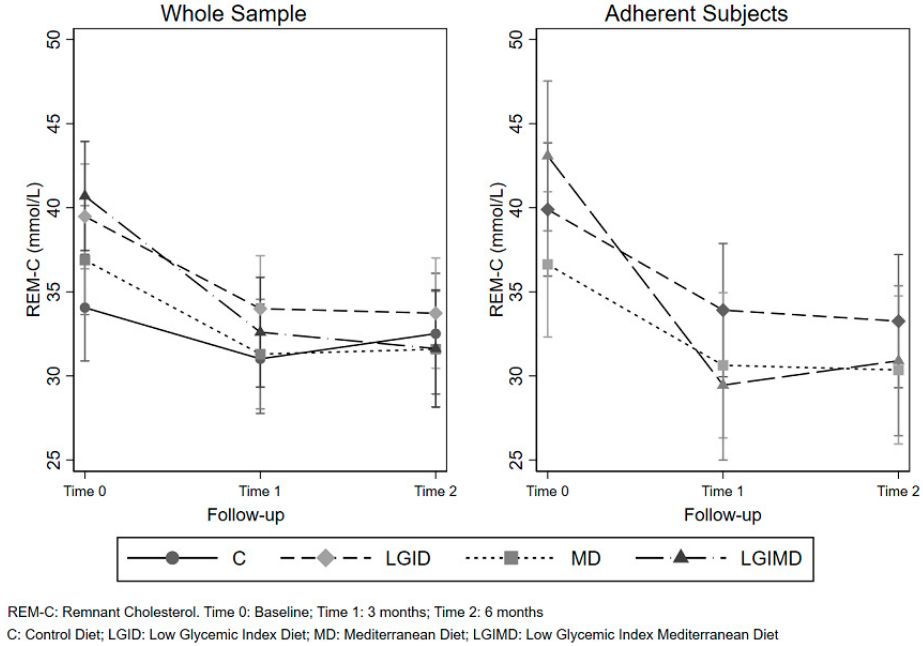
Figure 2. Repeated measures analysis of variance. Marginal effects of diet and time on remnant cholesterol.